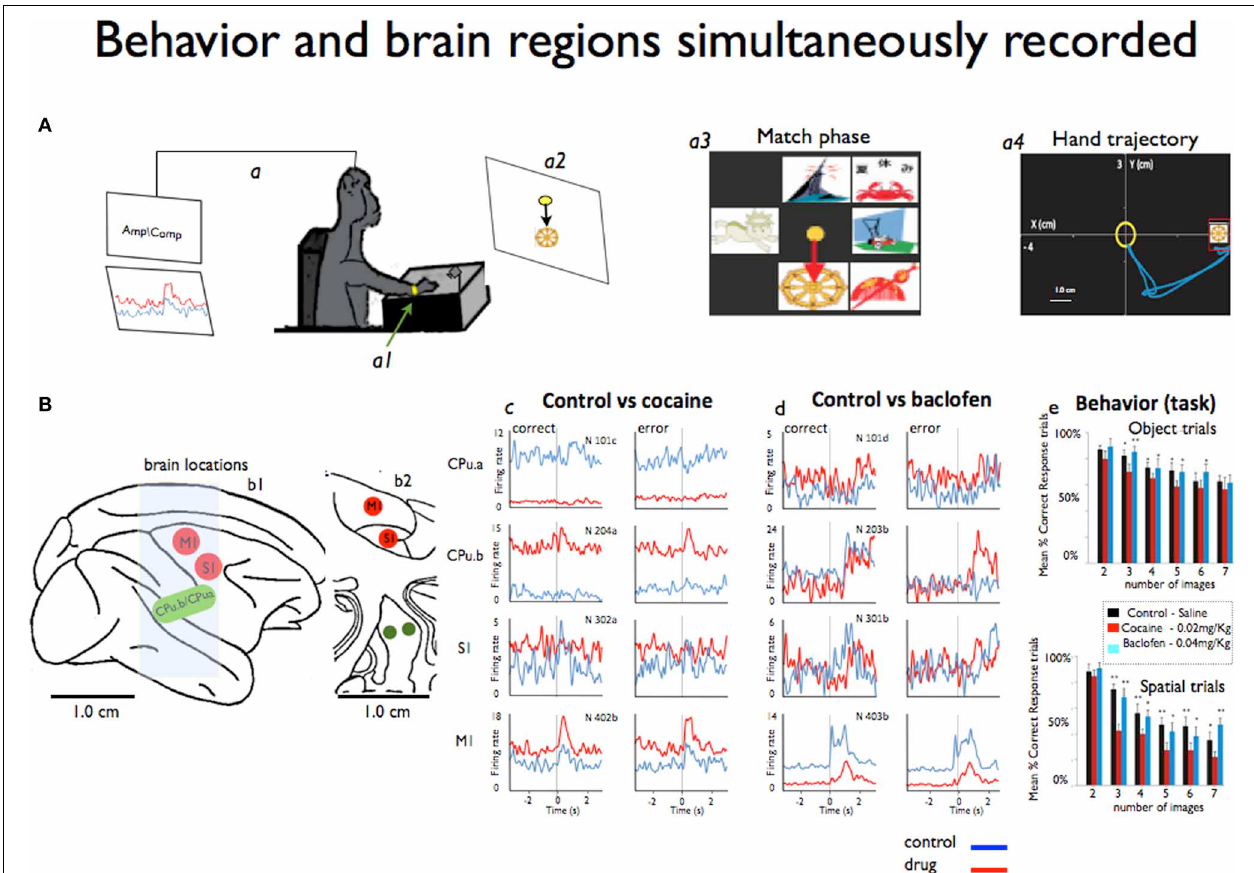
FIGURE 1 | Simultaneous recording of behavior and neural activity from four different brain regions. (A) A monkey performs the delayed match-to-sample (DMS) task while sitting at the behavioral apparatus attached to the recording brain (a) activity (Amp/Comp) and the position of the right arm is tracked via an illuminated UV- fluorescent reflector (a1) . The display screen shows an image sample (a2) and in more detail the match phase in which the sample phase image was presented with distracting images (a3) . Also shows an example of the x-y hand trajectories (a4) during target selection. (B) The sagittal view of the four brain regions (b1) recorded from during the behavioral task: M1: motor cortex, S1: somatosensory